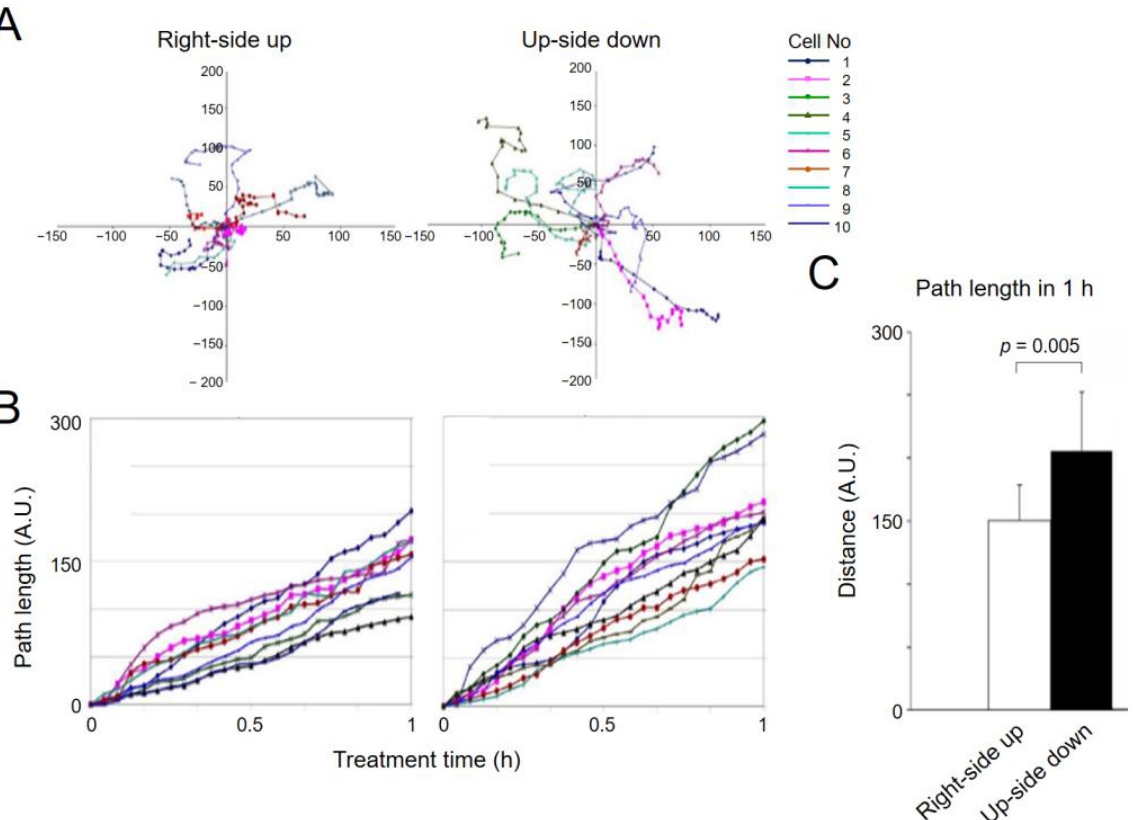
Figure 5. Increased migratory activity of upside-down cells. Migration of sparsely cultured BAECs in a Sykes chamber were tracked for 1 h before ( right-side up ) and after ( upside down ) flipping the chamber. The centroid positions of the nucleus of each cell at different times are plotted. ( A ) Trace of cell migration. The cell position at time 0 is superimposed at the X-Y intersection. ( B ) The data in A are replotted to show the rate of cell migration. Note that upside-down cells move faster. ( C ) Total migration path lengths of right-side up and upside-down cells. Upside-down cells exhibit increased cell migration. The migration path lengths in A.U. represent pixel numbers, and 10 A.U. corresponds approximately 1 µ m. Motility assays were independently repeated three times, all showing the same effect. One set of data are presented in this figure. p -value was determined by t -test.